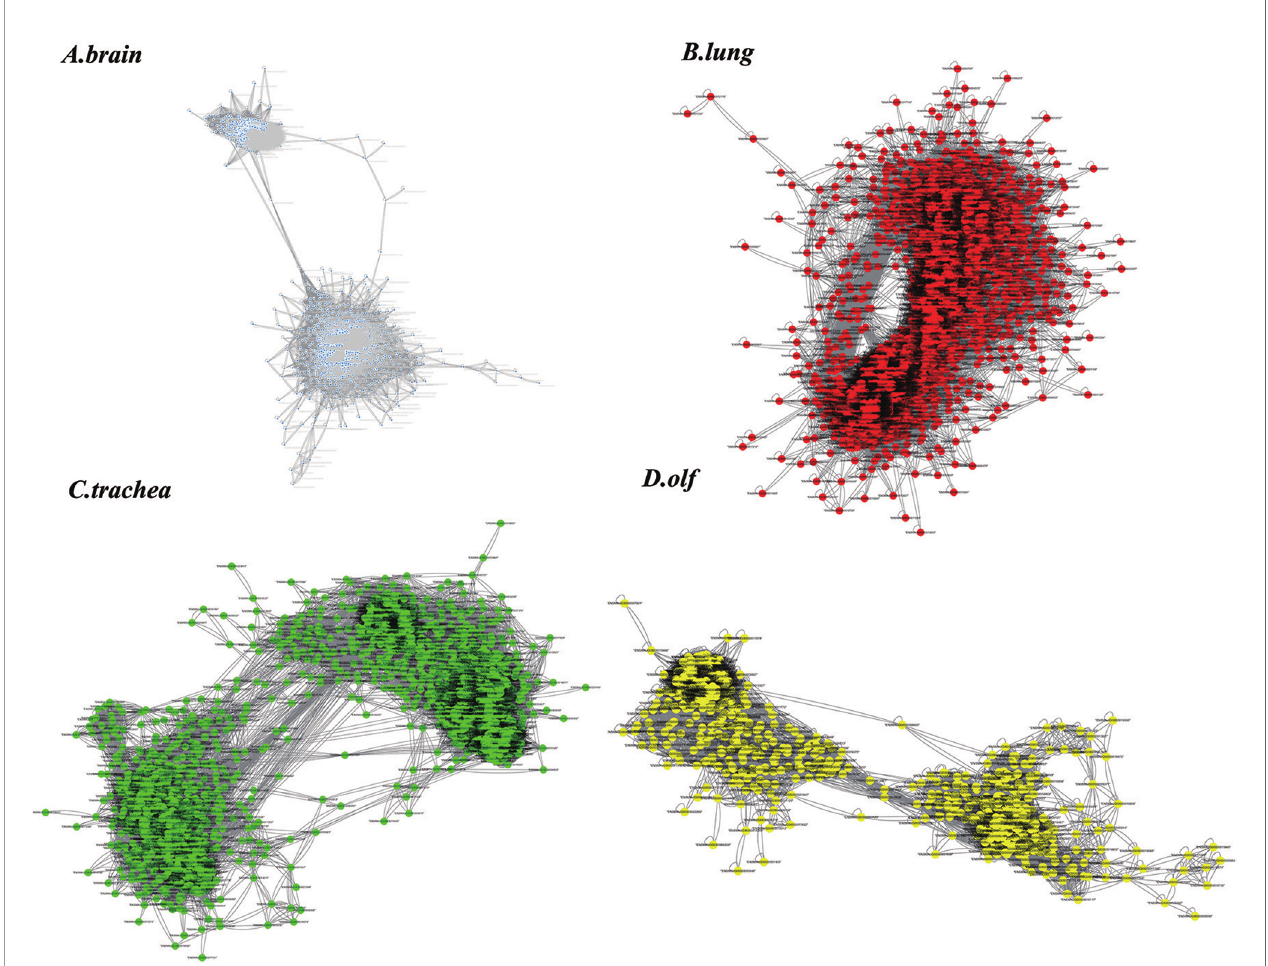
FIGURE 3 | The results of the time-order gene co-expression network (TO-GCN) analysis in the (A) brain, (B) lung, (C) trachea, and (D) olf. The colored dots represent the screened